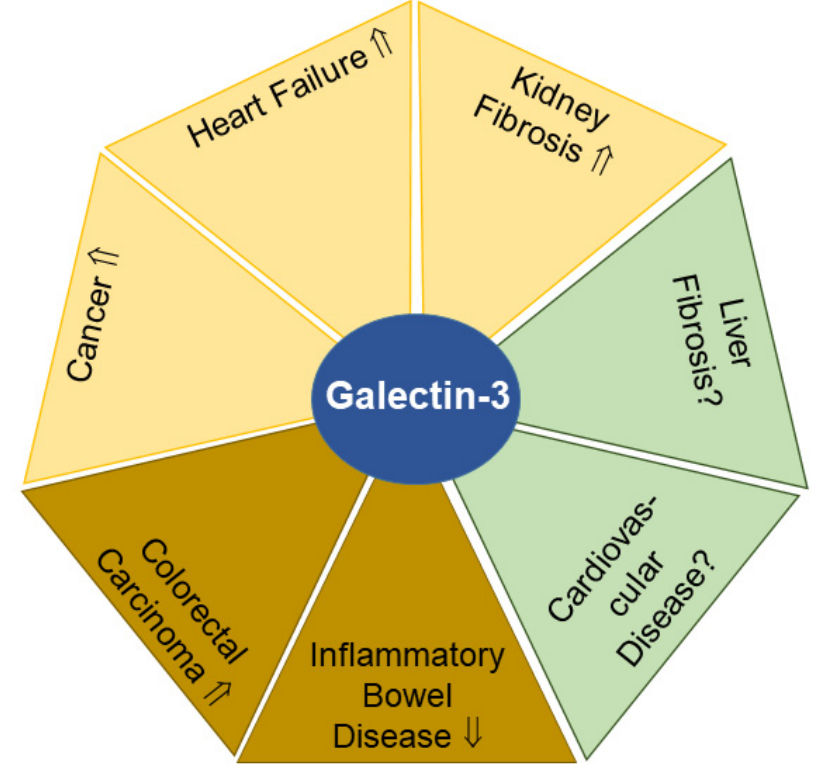
Figure 4. Galectin-3 levels in urine (yellow) and feces (light brown) have potential to serve as biomarkers for the indicated diseases. In liver fibrosis and cardiovascular diseases (green), the diagnostic and prognostic value of urinary and/or fecal galectin-3 remains to be clarified. Elevated ( ⇑ ) or reduced ( ⇓ ) galectin-3 levels and a lack of data on galectin-3 amounts (?) in urine or feces in patients compared to the respective controls are